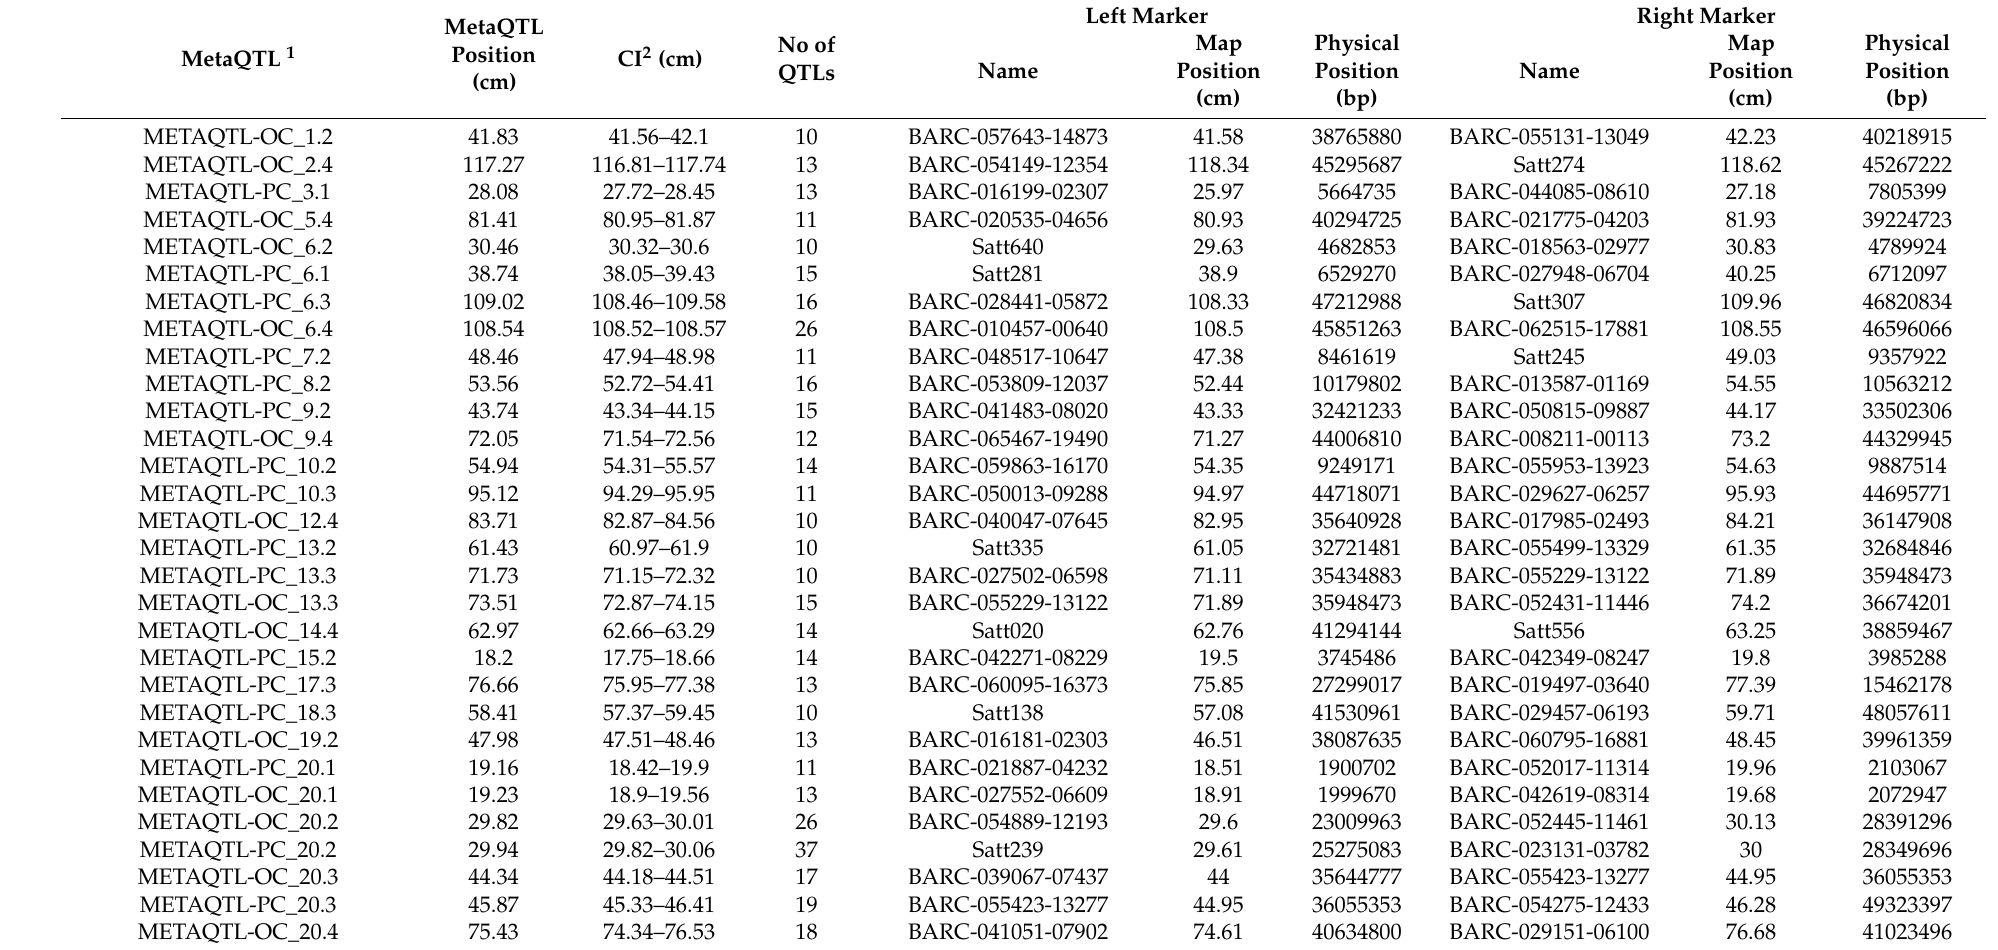
Table 1. Details of significant meta-quantitative trait loci (meta-QTLs) identified for seed oil and protein content in